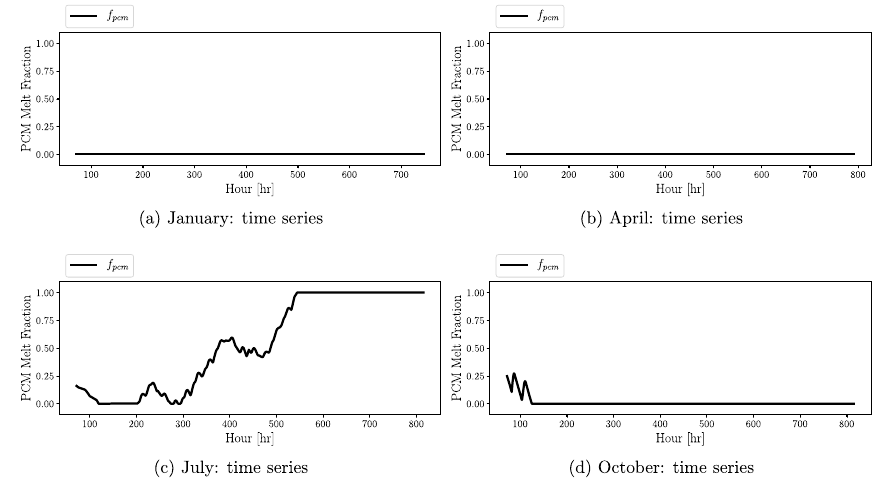
Figure A5. PCM melt fraction: time series ( a – d ) of PCM melt